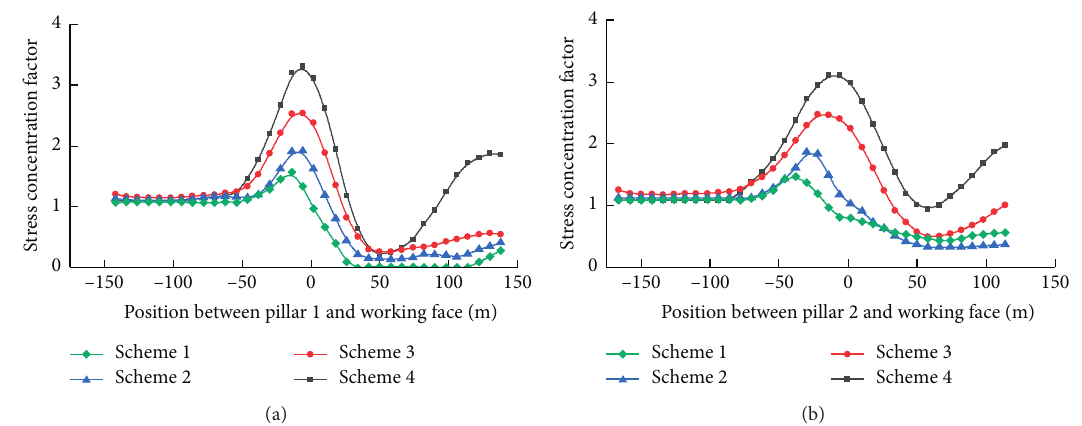
Figure 9: Stress evolution in different coal pillars affected by mining activities.